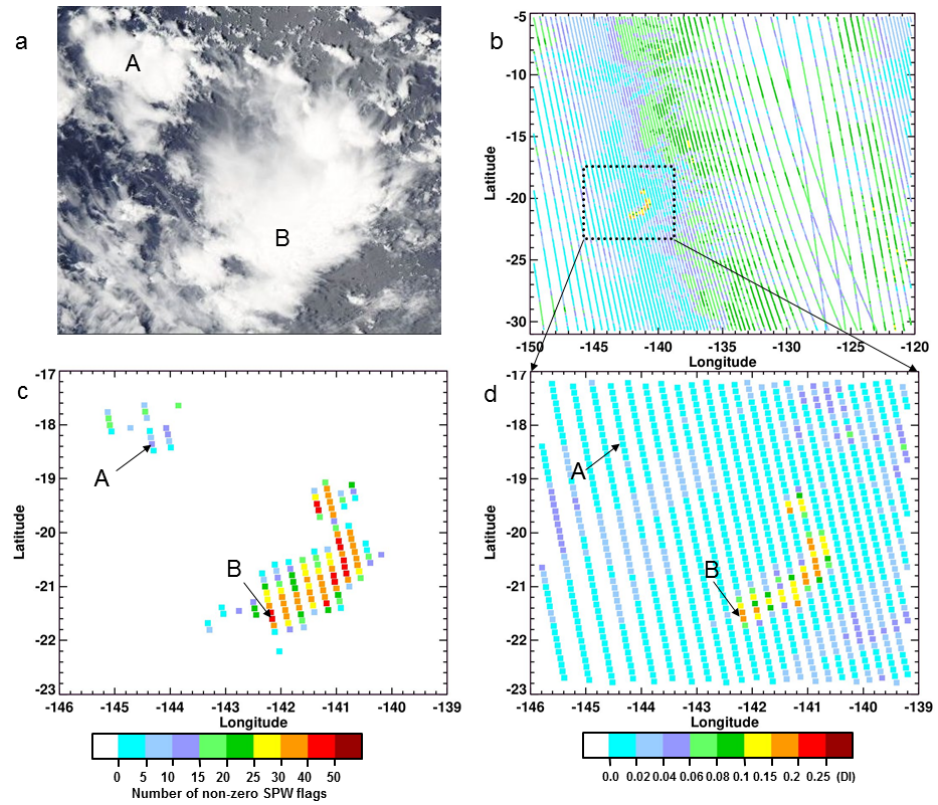
Figure 1. Two cloud zones in the south Pacific on 14 January 2006 for orbit 7990: small northern zone labeled “A” and large southern labeled “B” (a) Aqua MODIS image; (b, d) DI maps for the vis spectral region (414–424nm); (c) the number of wavelengths for a given pixel marked with the SPW flag as saturated (the maximum number is 51 in this vis spectral